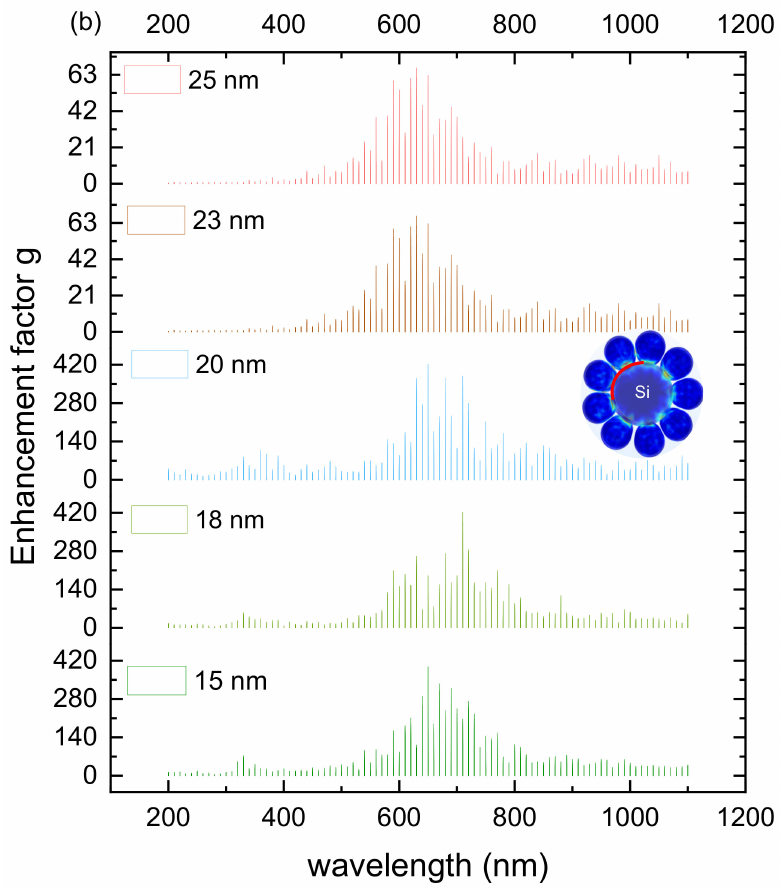
Figure 2. ( a ) Energy level diagram of the coupling of plasmon modes of the heterogeneous antenna. ( b ) 3D simulation of the electromagnetic field enhancement (near-field enhancement) in the silicon nanoantenna surrounded by a Ag/Au core-shell nanospheres. The model is the air domain for different interparticle distances ( d int = 15 nm, 18 nm, 20 nm, 23 nm, 25 nm), silicon nanoantenna radius r Si = 10 nm and length L Si = 70 nm, Ag/Au core-shell nanospheres radius r Ag@Au = 5 nm. The inset shows the red line where the electromagnetic field was collected on the surface of the Si